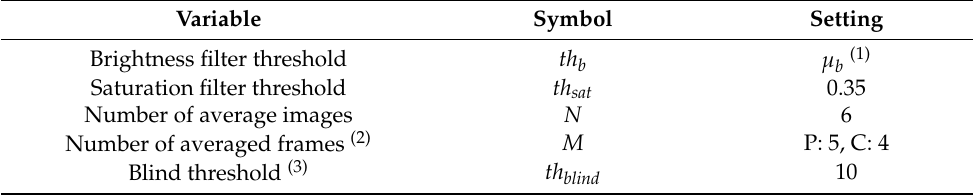
Table 5. Variables setting for registration error parameter estimation.